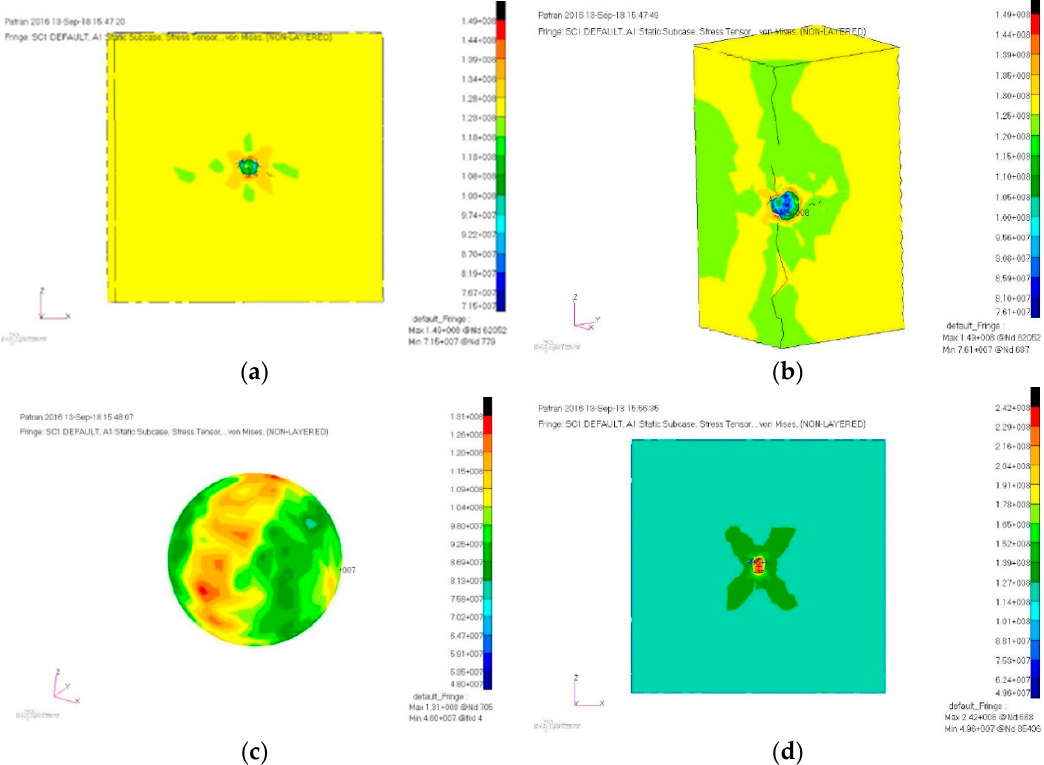
Figure 16. Von Mises illustration of the ( a ) cube-cell cross-section view, ( b ) cube-cell quarter view, ( c ) filled microcapsule, and ( d ) base cube-cell with an empty microcapsule.